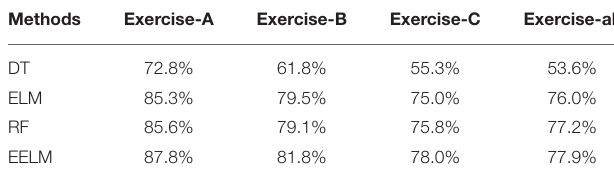
TABLE 1 | Overall motion recognition accuracy by different methods. Methods